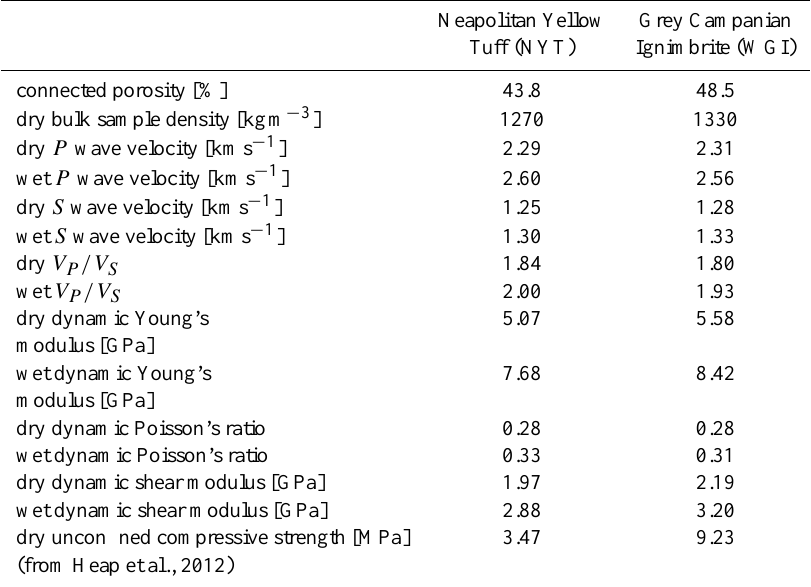
Table 1. Summary of the ambient pressure, as-collected physical properties of NYT and WGI. “Dry” indicates measurements on samples that were dried in a vacuum oven for at least 24h; the measurements were then performed under ambient laboratory humidity. “Wet” indicates measurements on samples that were vacuum-saturated with distilled